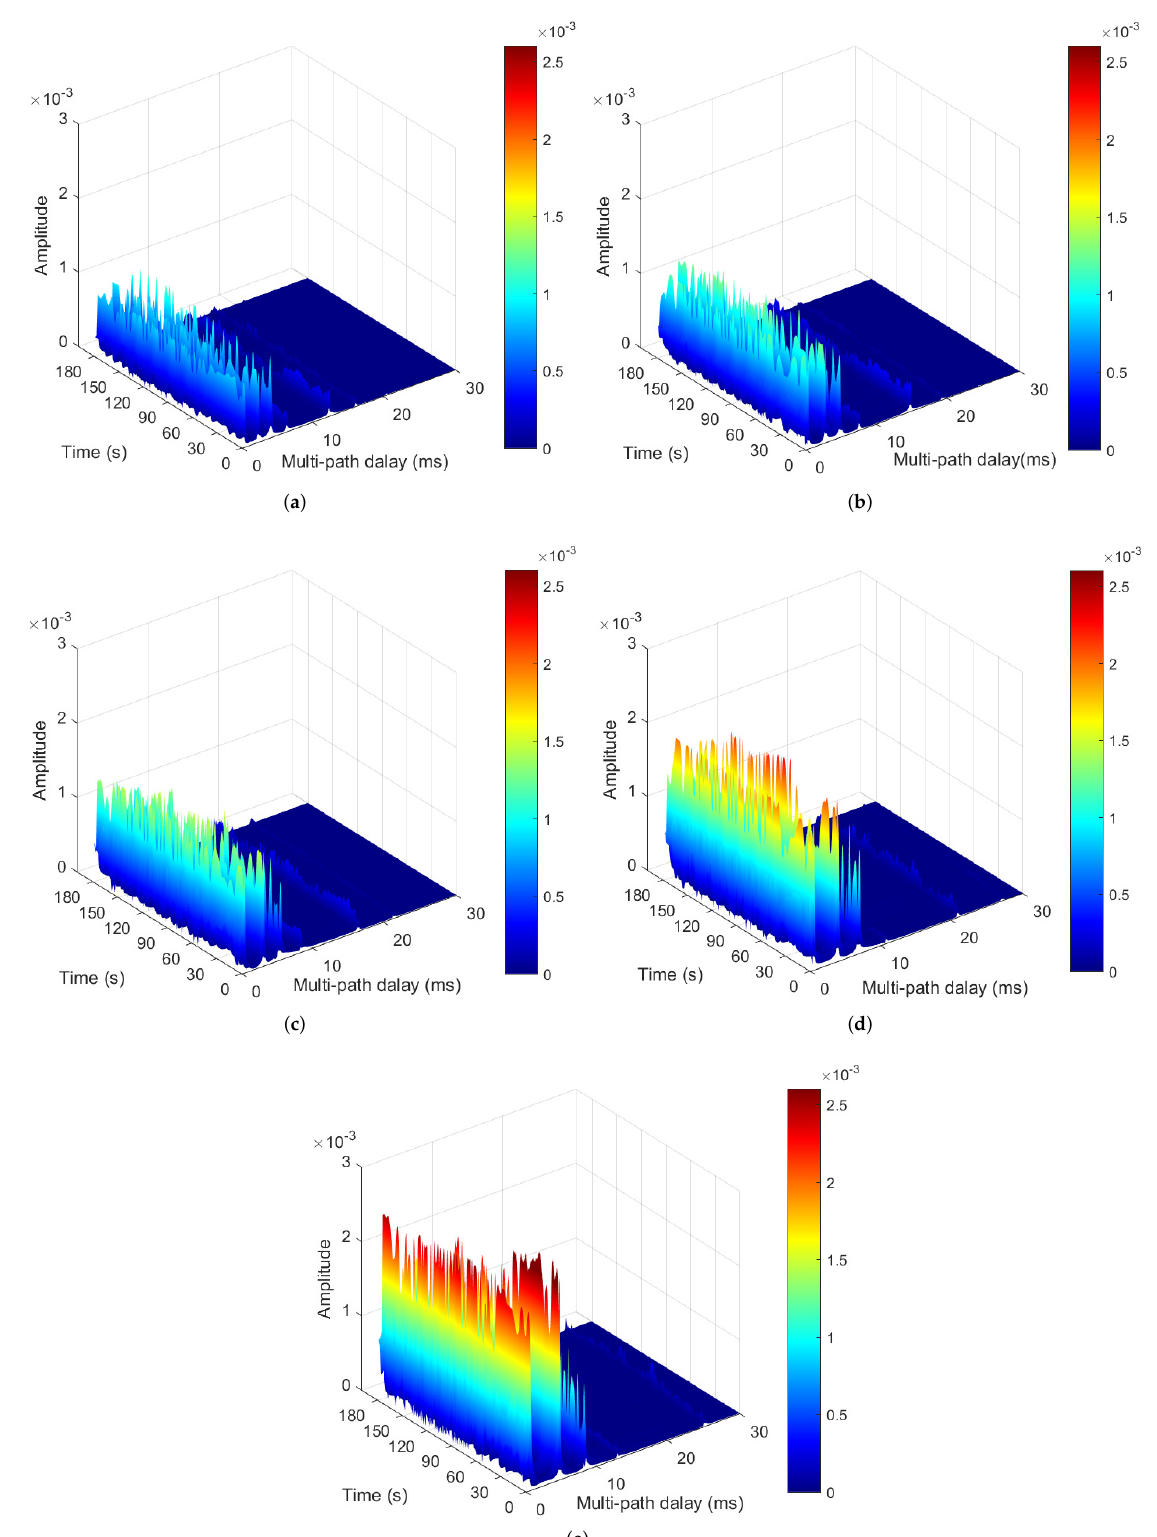
Figure 6. Channel impulse responses from sensors nodes to destination node. ( a ) Received CIR by D sent from S , d = 3 km. ( b ) Received CIR by D sent from r 1 , d = 2.5 km. ( c ) Received CIR by D sent from r 2 , d = 2.25 km. ( d ) Received CIR by D sent from r 3 , d = 1.75 km. ( e ) Received CIR by D sent from r 4 , d = 1.45